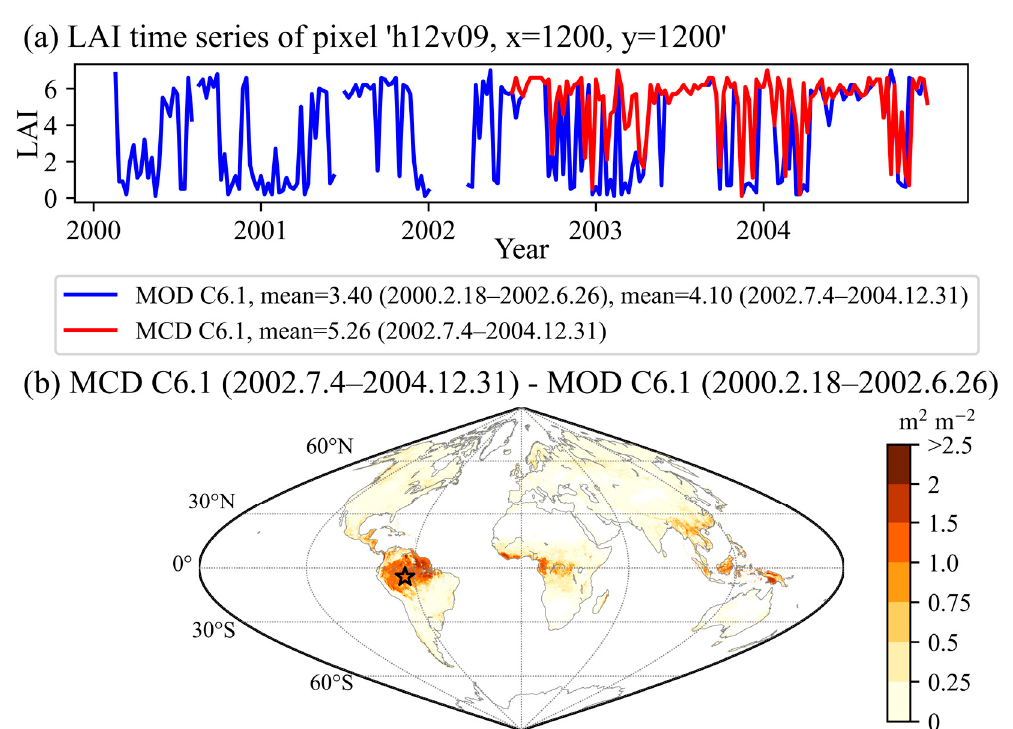
Figure 11. Difference in temporal mean value between MCD15A2H C6.1 and MOD15A2H C6.1 LAI products at ( a ) pixel ‘h12v09, x = 1200, y = 1200’ (lat = − 4.998, lon = − 65.250), and ( b ) the global scale. The black star in ( b ) indicates the location of the pixel plotted in ( a